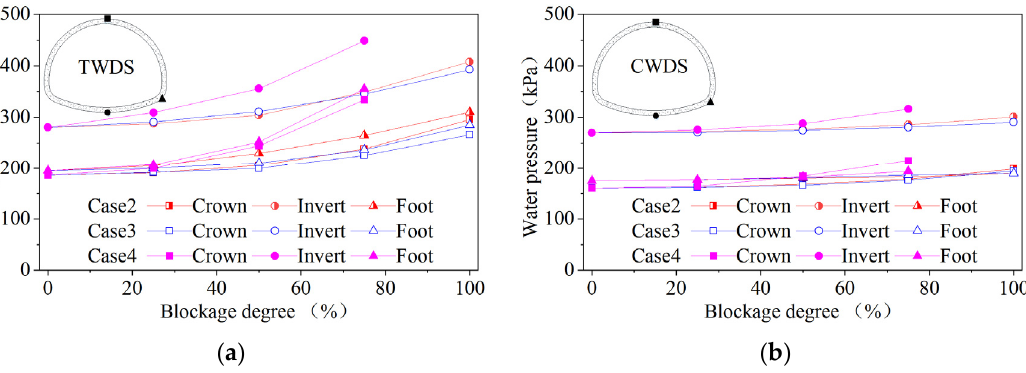
Figure 10. The evolution of water pressure under different work conditions: ( a ) Section 1 of TWDS; ( b ) Section 2 of TWDS.